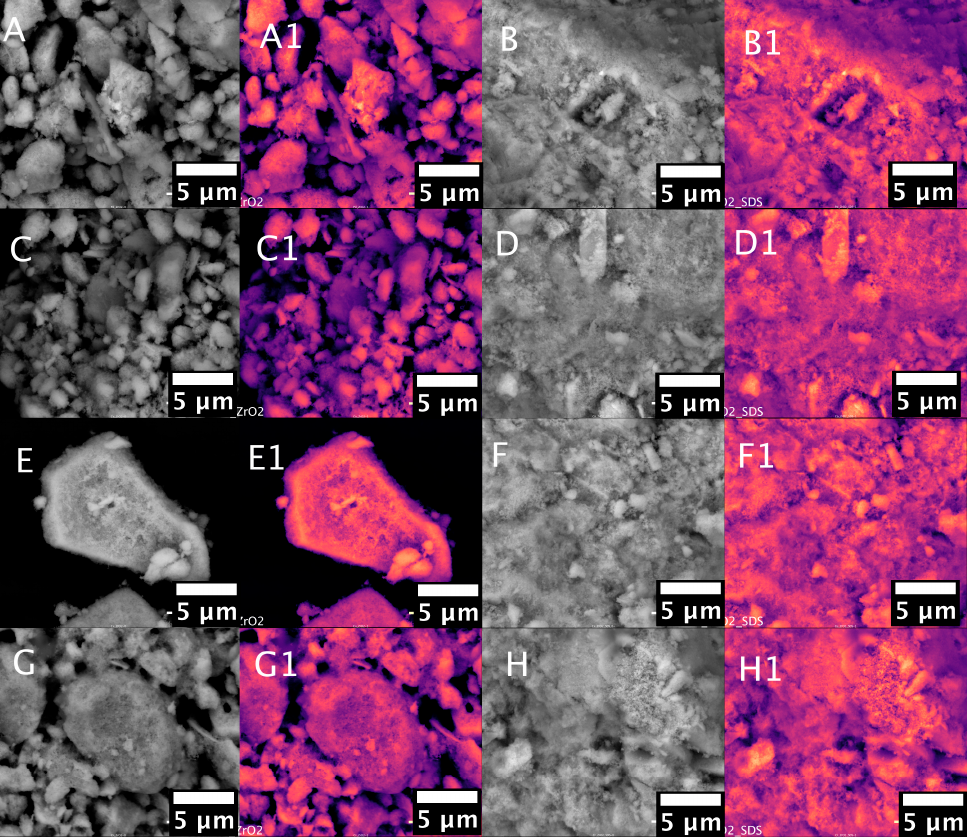
Figure 2. SEM micrographs of prepared catalyst samples: ( A ) Pd/ZrO 2 ; ( B ) Pd/ZrO 2 /SDS; ( C ) Co/ZrO 2 ; ( D ) Co/ZrO 2 /SDS; ( E ) Cu/ZrO 2 ; ( F ) Cu/ZrO 2 /SDS; ( G ) Cr/ZrO 2 ; ( H ) Cr/ZrO 2 /SDS; suffix 1 refers to coloured SEM.